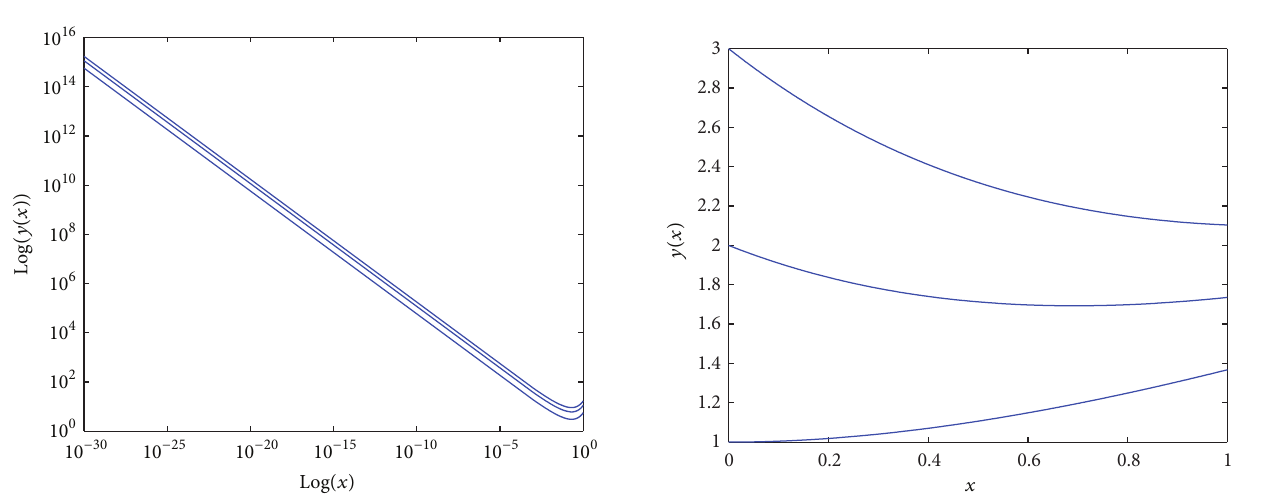
Figure 2: Solution of Example 4, Case I, 𝛽 = 0.5 .